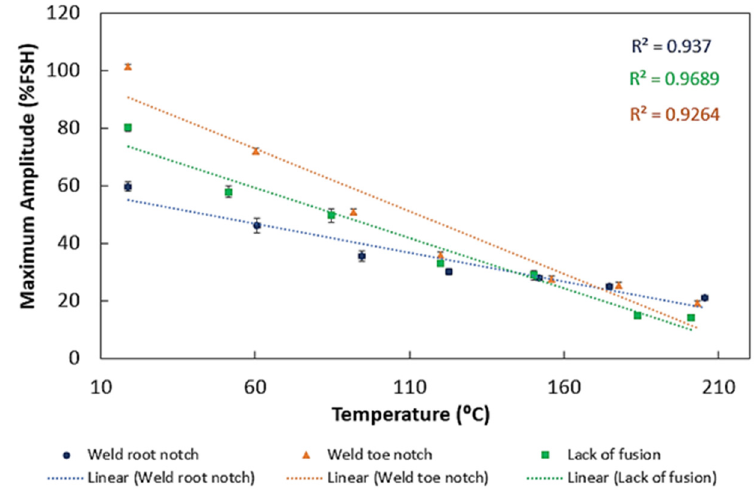
Figure 9. Variation of the maximum amplitude with the temperature for different defects.